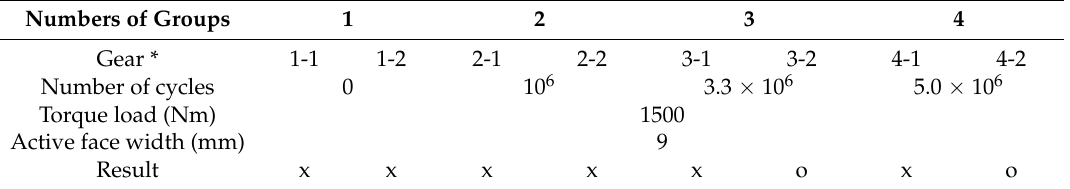
Table 3. Details of experimental tests on helical gears.